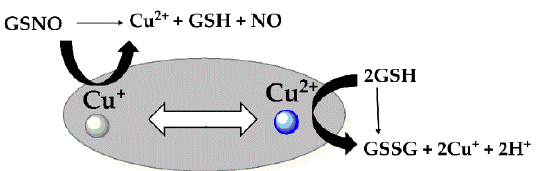
Figure 5. The schematic presentation of the mechanism of nitric oxide (NO) generation from GSNO in the presence of GSH in phosphate-buffered saline (PBS).